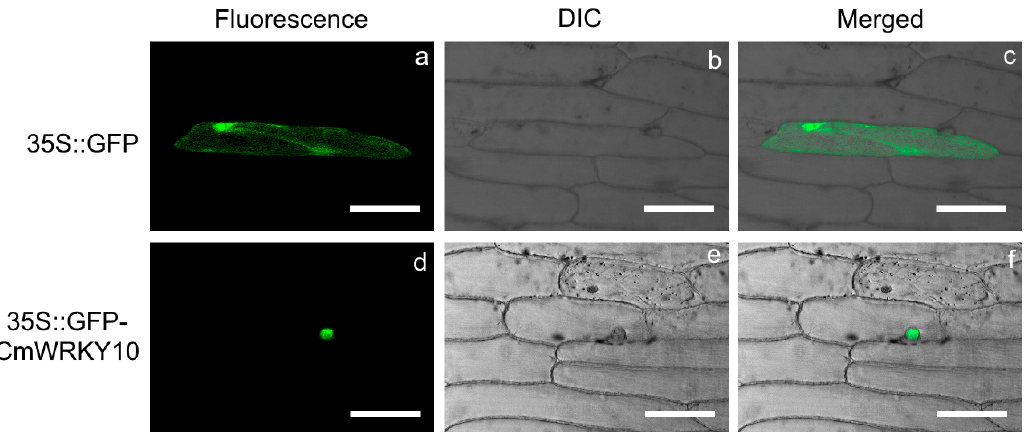
Figure 3. Subcellular localization of CmWRKY10 protein in onion epidermal cell. GFP (upper panel) and GFP::CmWRKY10 (lower panel) fusion proteins were transiently expressed under the control of CaMV35S promoter and photographed with Zeizs Microsystem LSM730. Images were taken in dark field for green fluorescence ( a , d ), in differential interference contrast (DIC) ( b , e ) while the combination of green fluorescence and bright field ( c , f ) were also photographed. Scale bars = 50 μ m.